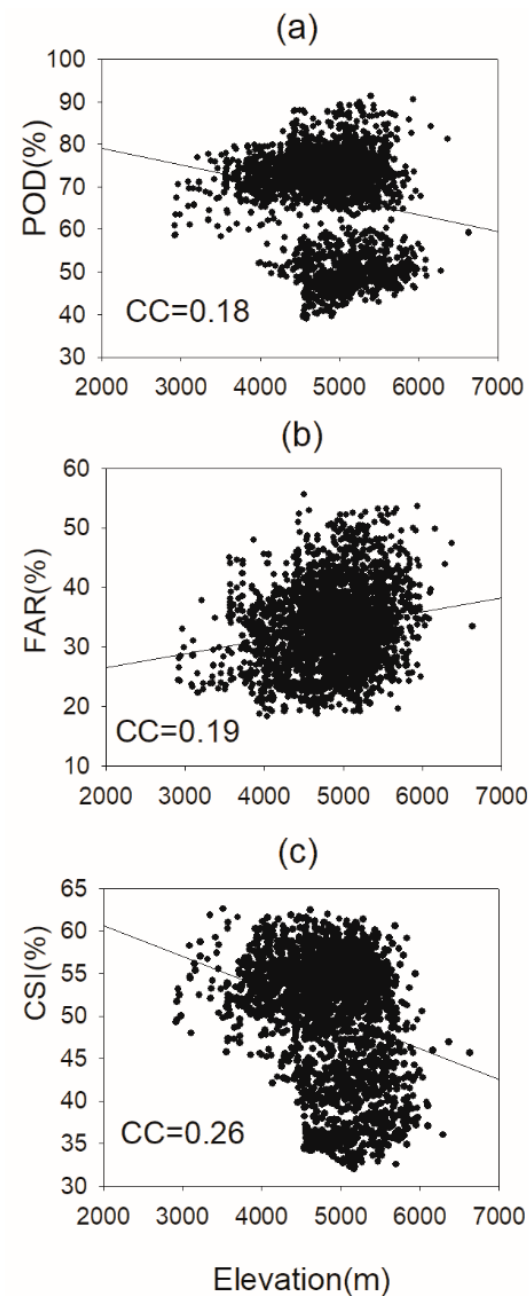
Figure 14. Relationship between the statistical metrics and the altitude for GPM: ( a ) POD, ( b ) FAR, and ( c ) CSI. Black lines show the linear trends estimated with the least-squares-error method. CC, correlation coefficient.